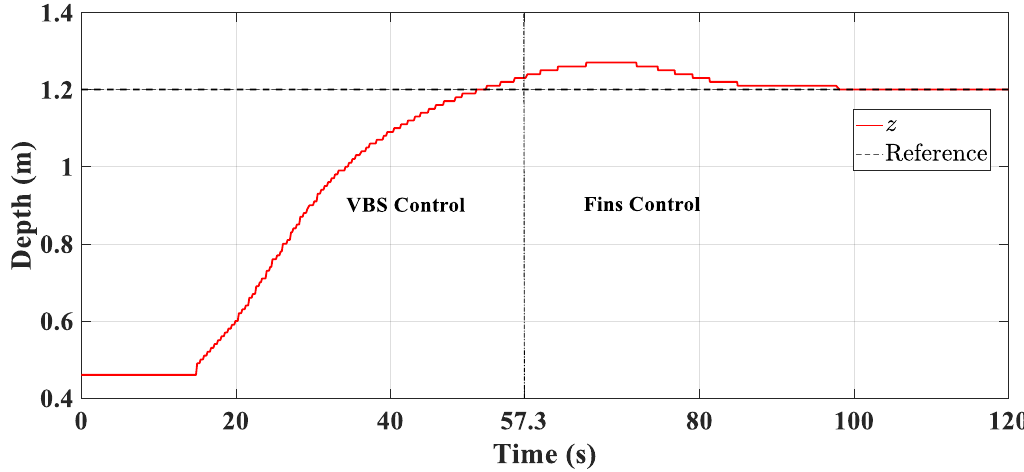
Figure 20. Depth response under combined control strategy.